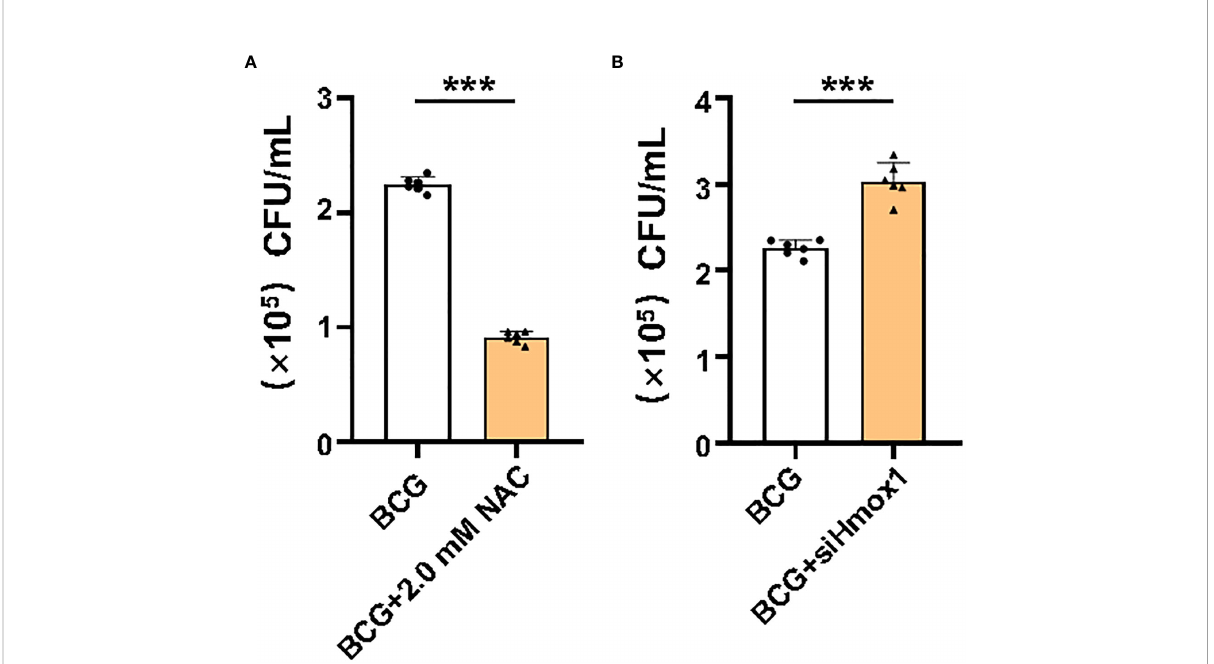
FIGURE 7 Effect of ROS and Hmox1 on intracellular bacterial loads in RAW264.7 macrophages. Intracellular ROS was scavenged by NAC treatment, and the expression of Hmox1 was inhibited by the transfection of siRNA to Hmox1 . NAC-pretreated or si -Hmox1 -transfected RAW264.7 macrophages were incubated with BCG at an MOI of 5 for 1 h, and cells were rinsed to remove uninfected bacteria prior to being cultured with fresh medium for an additional 24 h. The bacteria released in the culture medium was counted by CFU assay. (A) The count of colonies in medium of cells pretreated with NAC. (B) The count of colonies in medium of cells transfected with si -Hmox1 . The NAC pretreatment signi fi cantly reduced bacteria released from cell necrosis/ferroptosis death, while si - Hmox1- mediated knockdown of Hmox1 gene strikingly increased CFU count in RAW264.7 cells infected with BCG. Data obtained from three independent experiments were processed using GraphPad Prism 8.0.1 software. Unpaired t -test was used to analyze the differential changes of the two groups. ***p < 0.001; n =